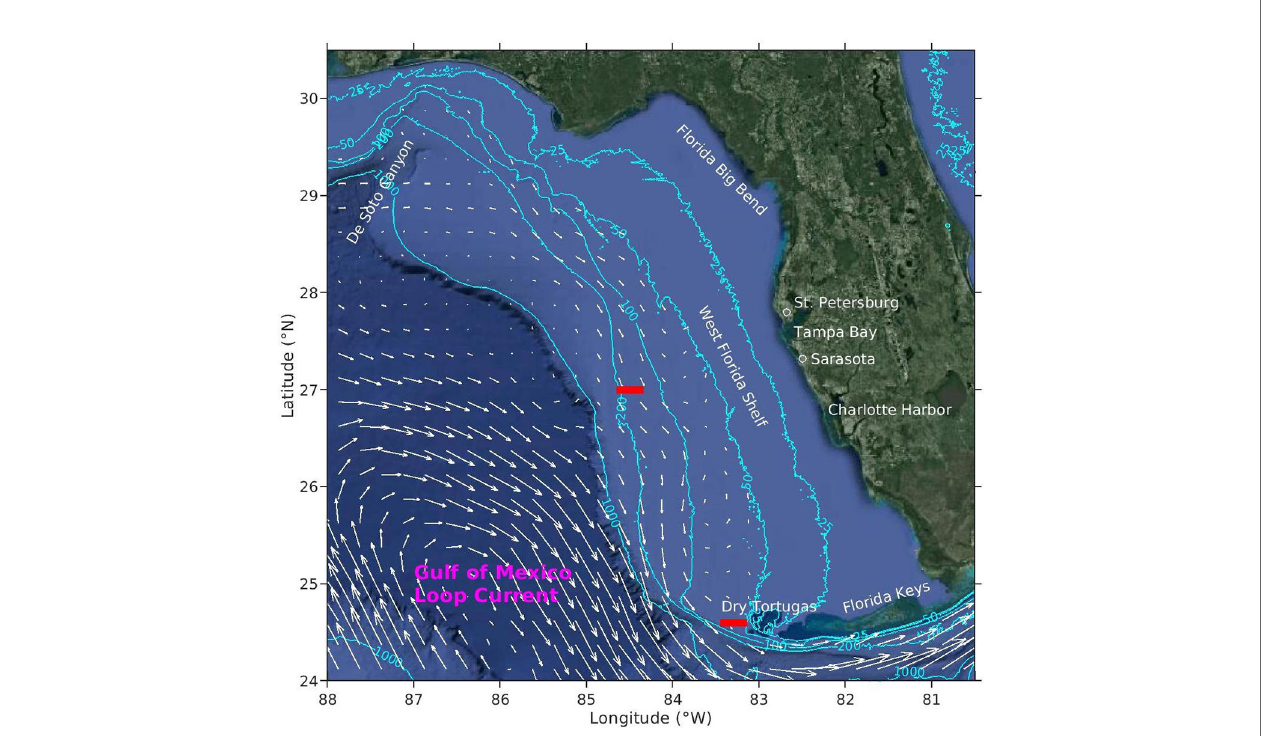
FIGURE 1 | The geometry of the WFS and the various locations referred to in the text. The red lines are of length equivalent to 30 km, the estimated WFS baroclinic, Rossby radius of deformation. Superimposed are surface geostrophic velocity vectors indicating the long-term mean position of the Gulf of Mexico Loop Current (adapted from Liu et al.,